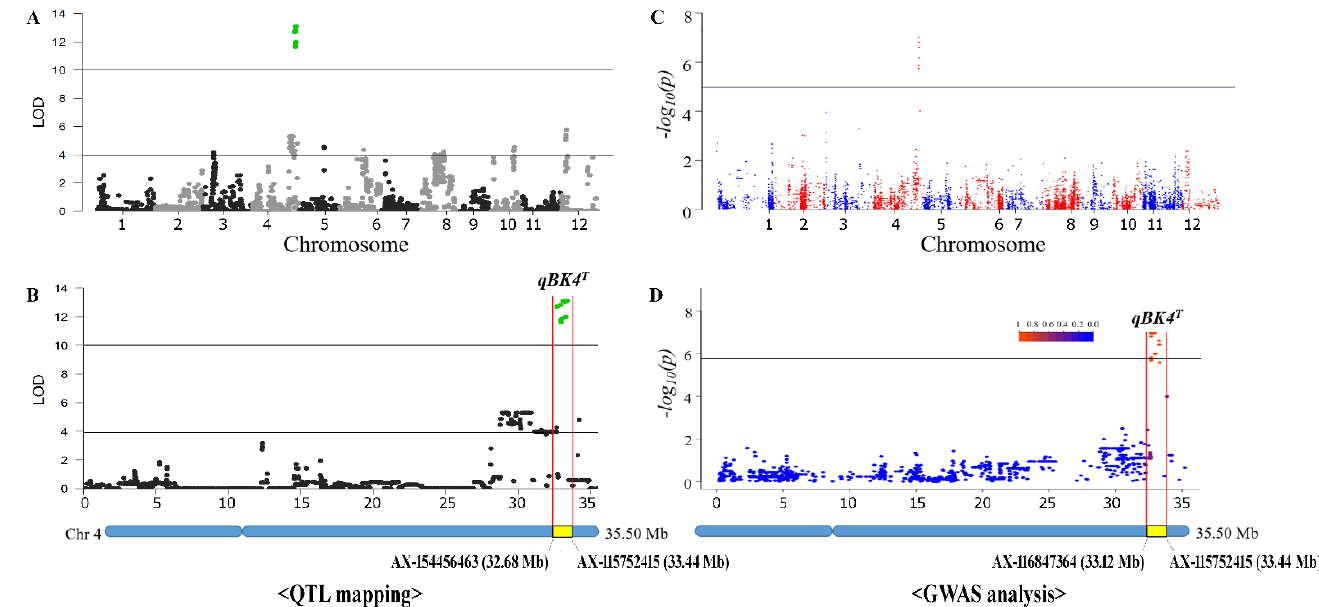
Figure 5. Manhattan plots of QTL mapping and GWAS analysis for bakanae disease resistance 143 BC 1 F 8 RILs. Markers plotted above the genome line recorded the topmost significant LOD by QTL mapping ( A ) and − log 10 ( p ) by GWAS analysis ( C ) as indicated by the black line. Manhattan plot displaying a zoom in of the qBK4 T locus on chromosome 4 tagged by QTL mapping ( B ) and GWAS analysis ( D ).